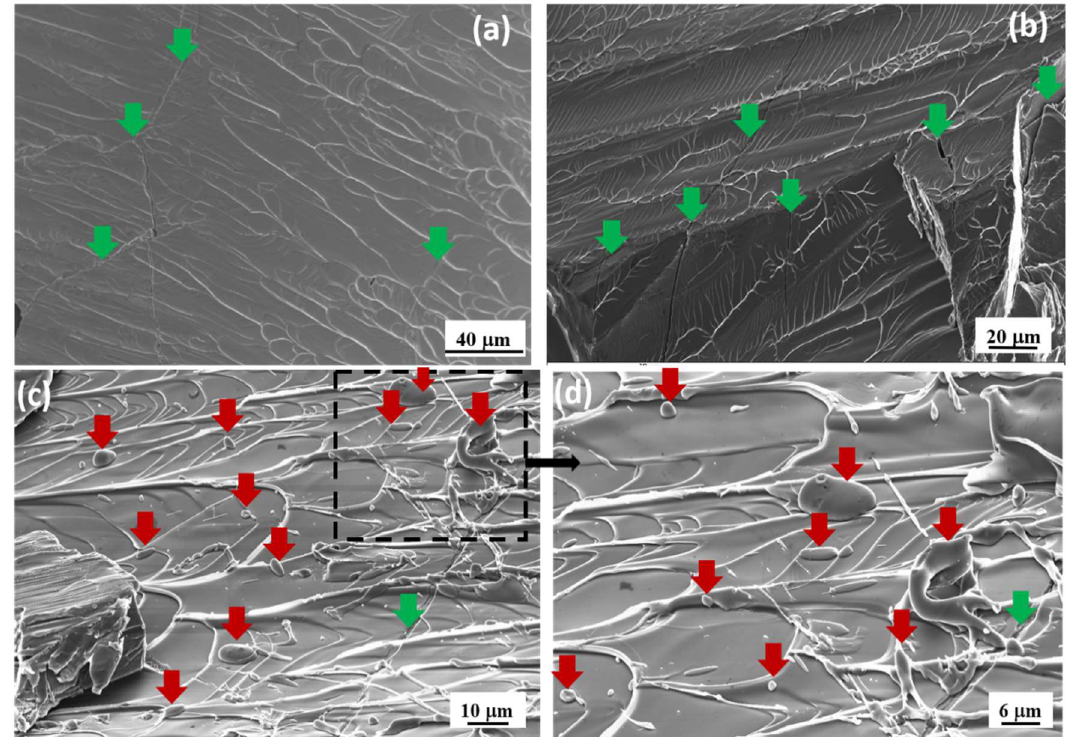
Figure 4. ( a ) and ( b ) SEM micrographs of a (FeCoBSiNb) 99 Ga 1 sample, showing the fracture surface after the compression test at different regions with different magnifications. Cracks are marked by green arrows; ( c ) (FeCoBSiNb) 98.5 Ga 1.5 sample, fracture surface at the center of the sample after the compression test and ( d ) center region at higher magnification (square region in ( c )). Droplets are marked by red arrows and cracks are marked by green arrows.